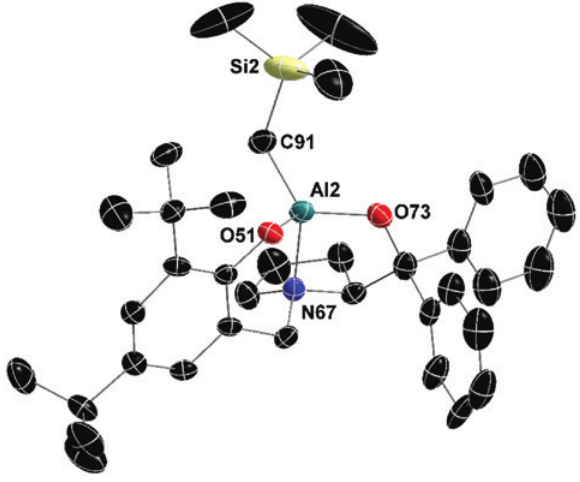
Figure 8: ORTEP rendering of the molecular solid-state structure of ( S )-{OˆO}AlCH SiMe ( 3 ). 2 3 One of the two independent molecules in the asymmetric unit is represented. Ellipsoids drawn at the 50% probability level. H atoms and non-interacting benzene lattice molecules omitted for clarity. Selected bond lengths (Å) and angles ( ° ): Al1-O23 = 1.742(3), Al1O1- 1.749(3), Al1-C41 = 1.949(5), Al1-N17 = 2.007(5), Al2-O73 = 1.731(4), Al2-O51 = 1.765(3), Al2-C91 = 1.937(5), Al2-N67 = 1.989(5); O23-Al1- O1 = 117.32(16), O23-Al1-C41 = 115.7(2), O1-Al1-C41 = 112.7(2), N67 = 100.05(17), C91-Al2-N67 = 116.9(2).